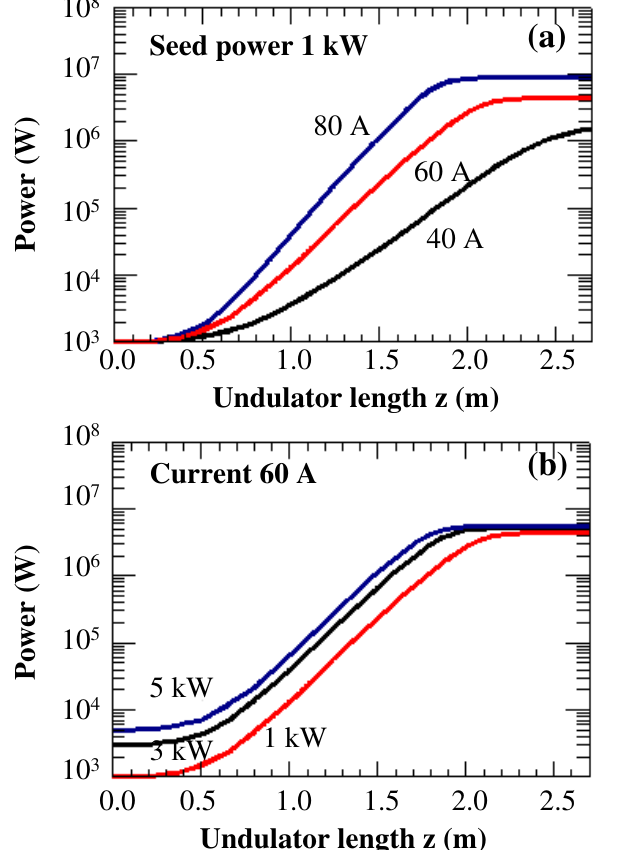
FIG. 1. (Color) Calculated THz power as a function of the undulator length z (a) for a fixed seed power of 1 kW and variable peak current of the electron beam, and (b) for a fixed peak current of 60 A and variable seed power level. Energy of the electron beam (cid:4) (cid:3) 19 : 5 , and (cid:3) (cid:3) 200 (cid:1) m